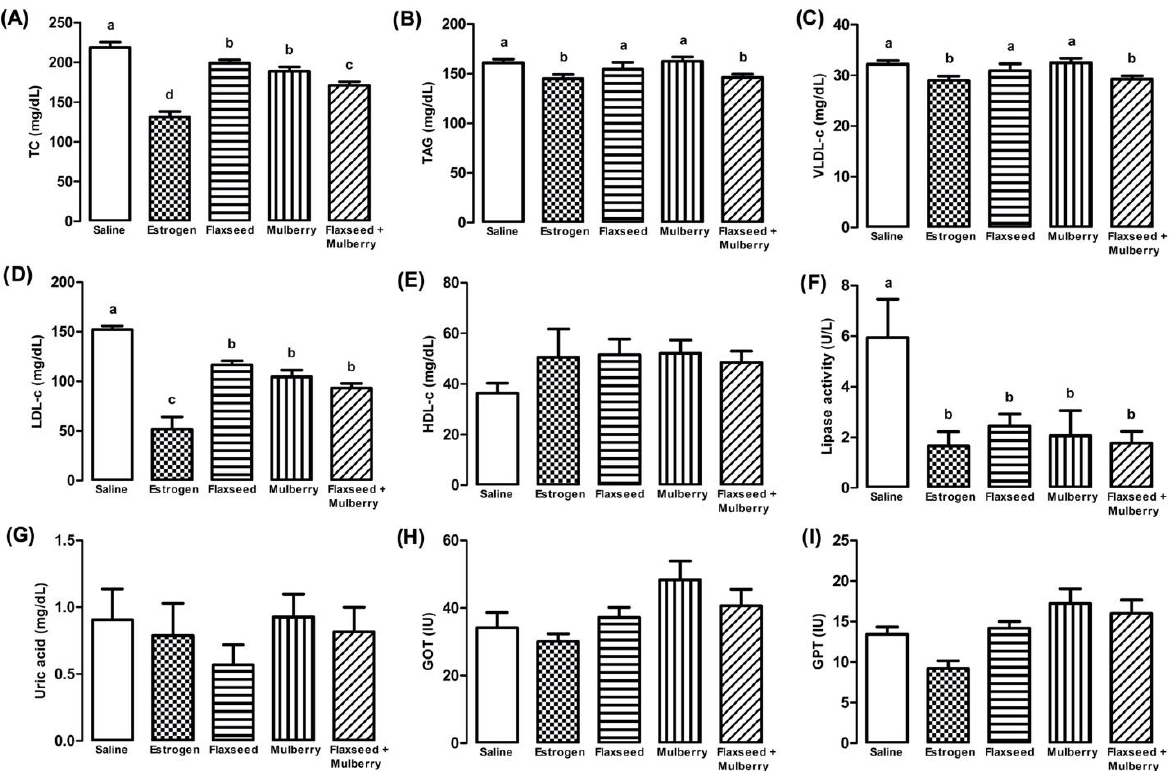
Figure 3. Plasma levels of total cholesterol (TC (mg/dL) ( A ), triacylglycerol (TAG (mg/dL) ( B ), very-low-density lipoprotein cholesterol (VLDL-c (mg/dL) ( C ), low-density lipoprotein cholesterol (LDL-c (mg/dL) ( D ), high-density lipoprotein cholesterol (HDL-c (mg/dL) ( E ), lipase activity (U/L) ( F ), uric acid (mg/dL) ( G ), glutamic-oxaloacetic transaminase (GOT (IU)) ( H ) and glutamic-pyruvic transaminase (GPT (IU)) ( I ) in animals treated with saline, estrogen, flaxseed extract, mulberry extract or flaxseed + mulberry. The bars with the same letter do not differ statistically from each other by the Scott – Knott test ( p < 0.05). Values represent means ± standard deviation.